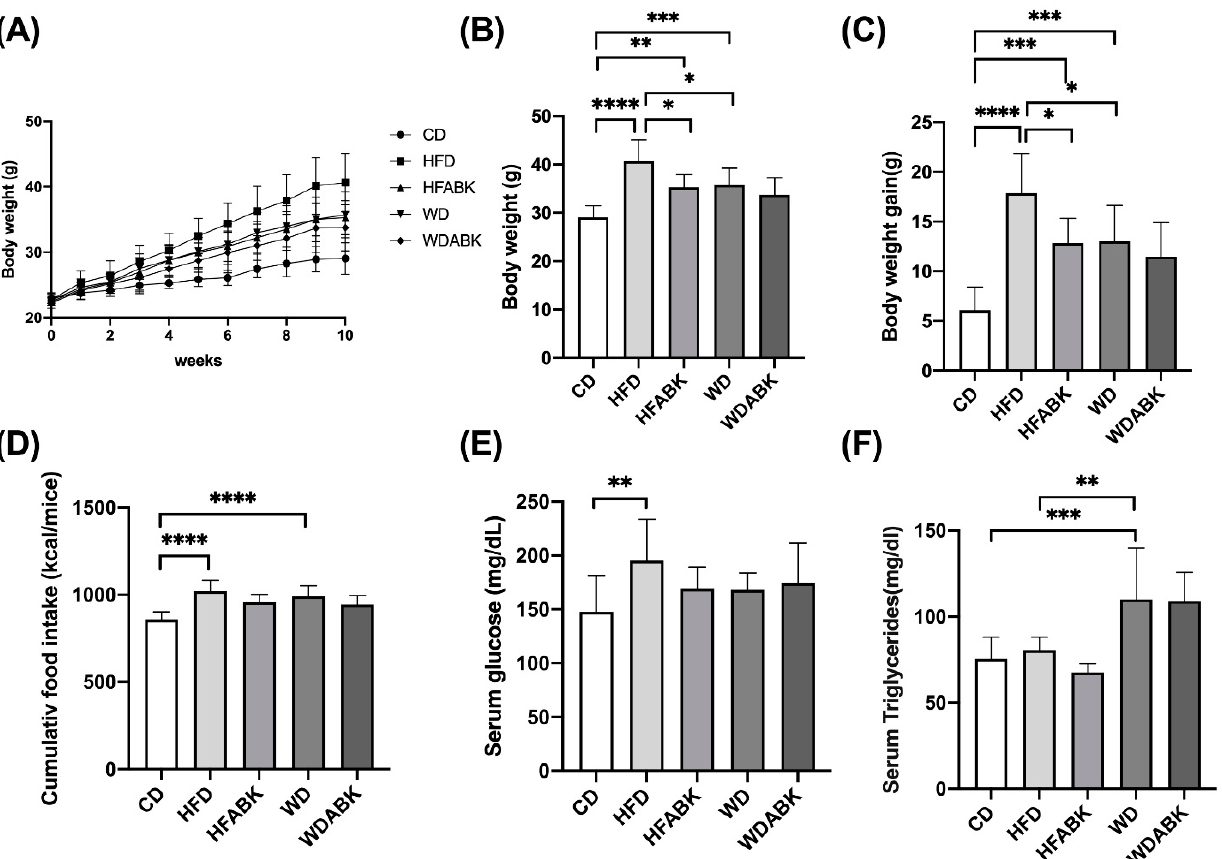
Figure 1. Effect of AB-Kefir on obesity in HFD- and WD-fed mice. Effect of AB-Kefir on ( A ) body weight for 10 weeks, ( B ) body weight at week 10, ( C ) body weight gain, ( D ) cumulative food intake, and serum levels of fasting ( E ) glucose and ( F ) triglycerides. Data are expressed as mean ± S.D. (n = 10 per group) * p < 0.05, ** p < 0.01, *** p < 0.001, **** p < 0.0001. Statistics were analyzed by using one-way ANOVA with Tukey’s post hoc test.